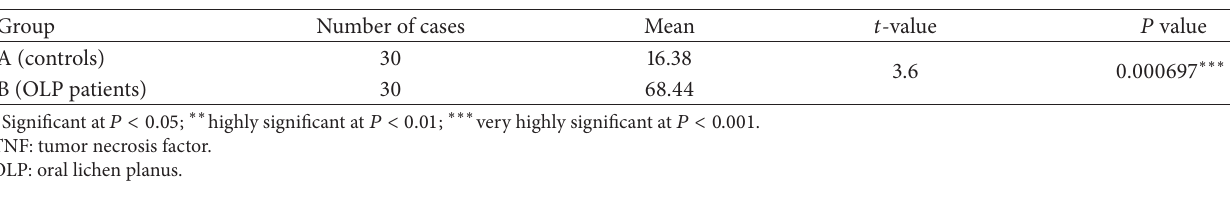
Table 3: Difference in proportion between detected and nondetected TNF- 𝛼 values in saliva of Group A and Group B.